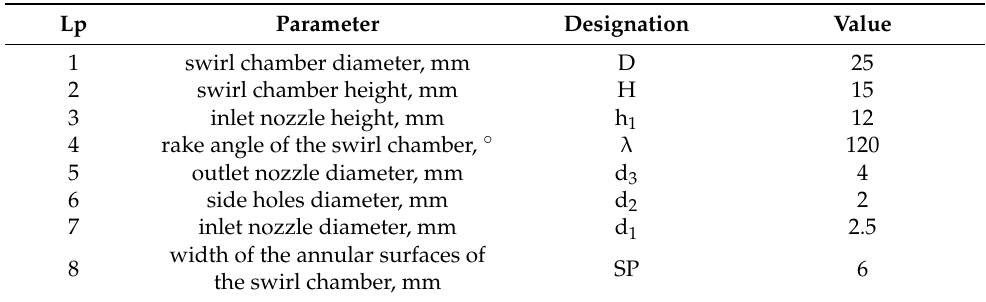
Table 5. Selected dimensional parameters of the selected model of a self-excited pulsation head intended for drilling holes with a water jet for pressures from 15 MPa to 150